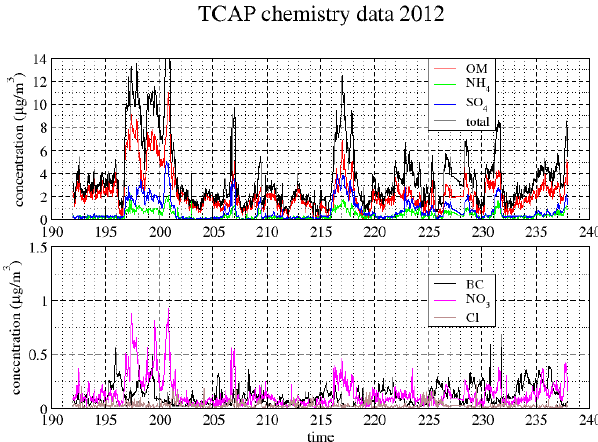
Figure 4. Time series of aerosol chemical components measured during the TCAP field experiment during summertime 2012. Here and in Figs. 5 and 6 time represents Julian day in 2012 (1 Jan- uary = 1). Days 190 and 214 correspond to 8 July 2012 and 1 Au- gust 2012, respectively. Organic matter (OM), ammonium (NH 4 ) , sulfate (SO 4 ) , nitrate (NO 3 ) , chloride (Cl), and total aerosol con- centrations are from ASCM measurements. Black carbon (BC) con- centrations are from SP2 measurements. The BC, OM, and ionic species are used to find the effective density and refractive index using the “chemical” method. Note the large mass fraction of or- ganic matter (OM), indicating that the aerosol is weakly absorbing at mid-visible